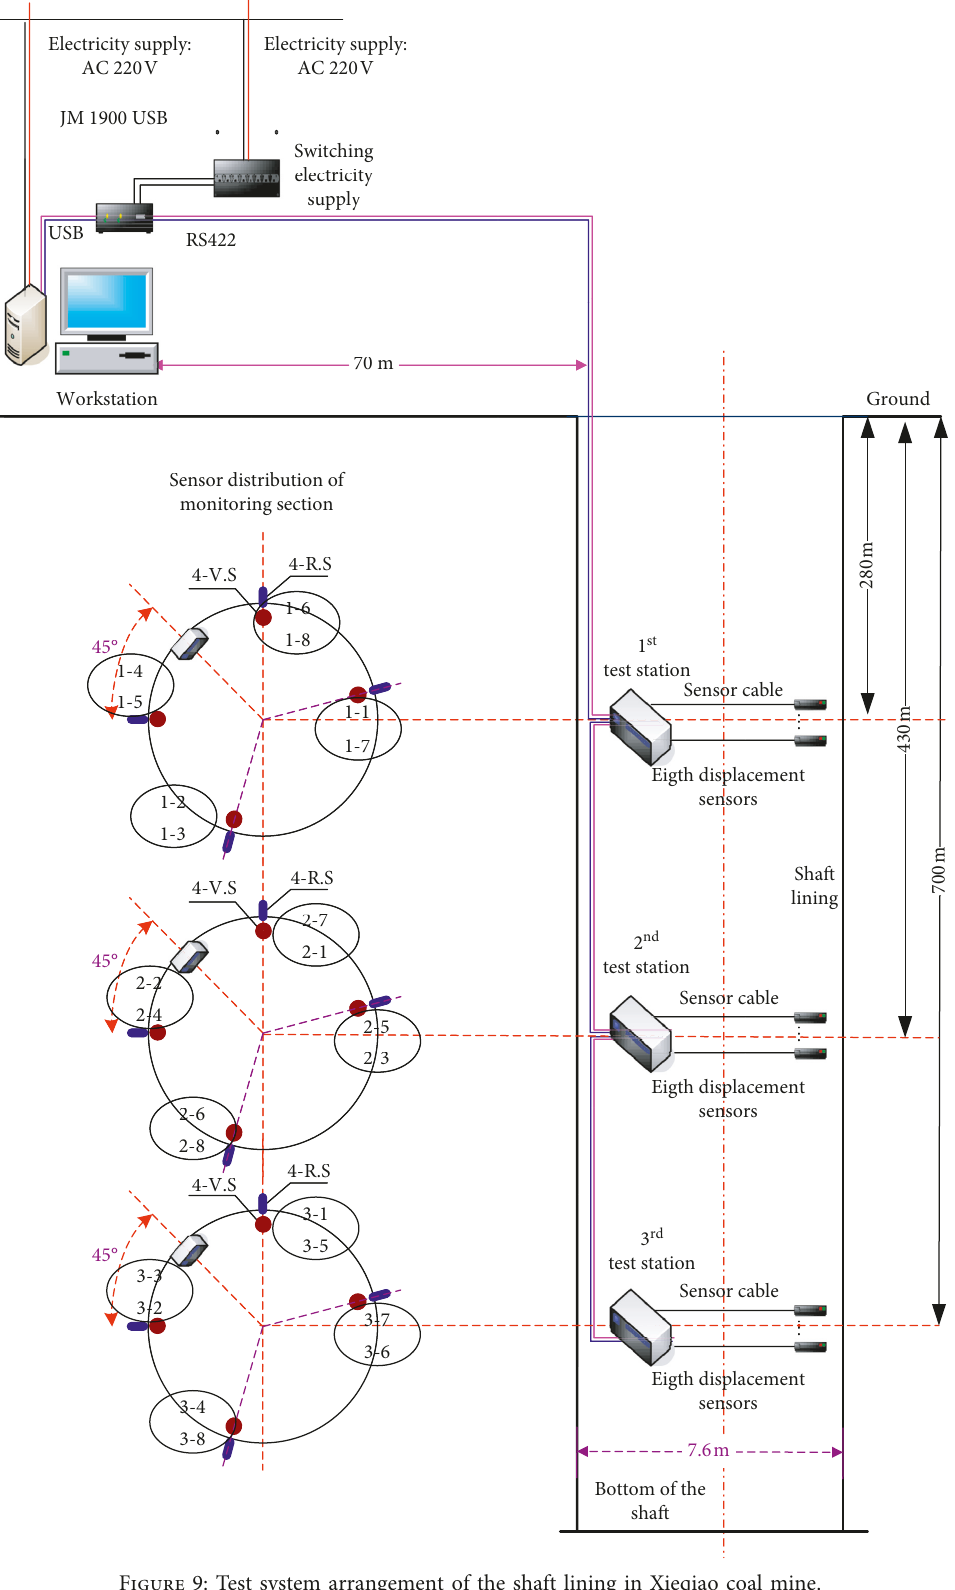
Figure 9: Test system arrangement of the shaft lining in Xieqiao coal